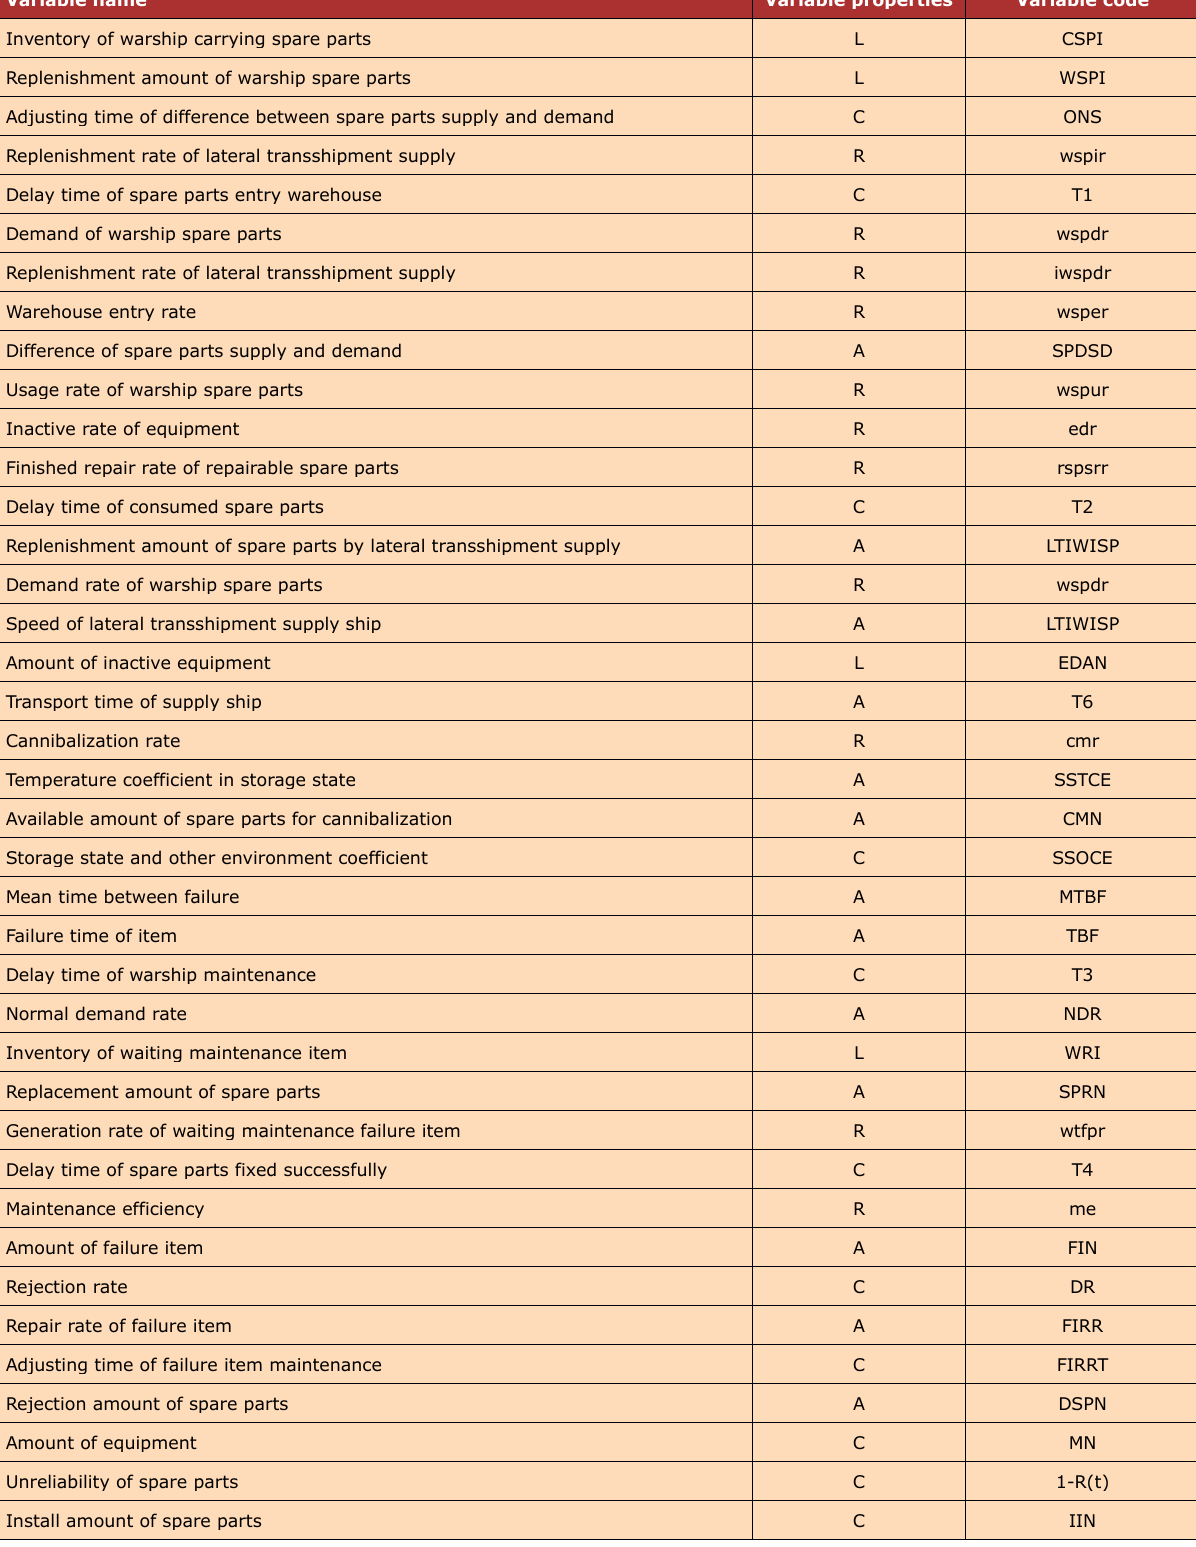
Table 1. Variable definition and